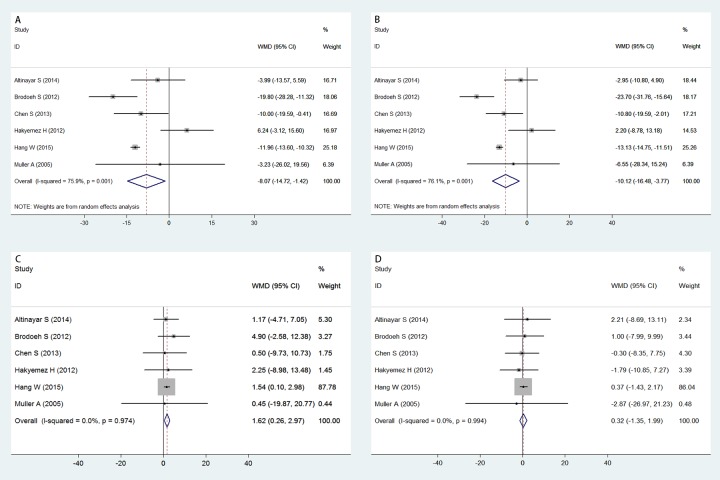
Forest plots of the meta-analysis for OB volume differences.PD patients vs healthy controls for right OB volume (A); PD patients vs healthy controls for left OV volume (B); OB volume in PD patients (C); OB volume in healthy controls (D). The size of the square surrounding each effect estimate indicates the weight of the individual study in the meta-analysis, and the horizontal bars indicate the corresponding 95% CIs. The diamond represents the pooled WMD, and the line width represents the 95% CIs. WMD = weighted mean difference; CI = confidence interval.